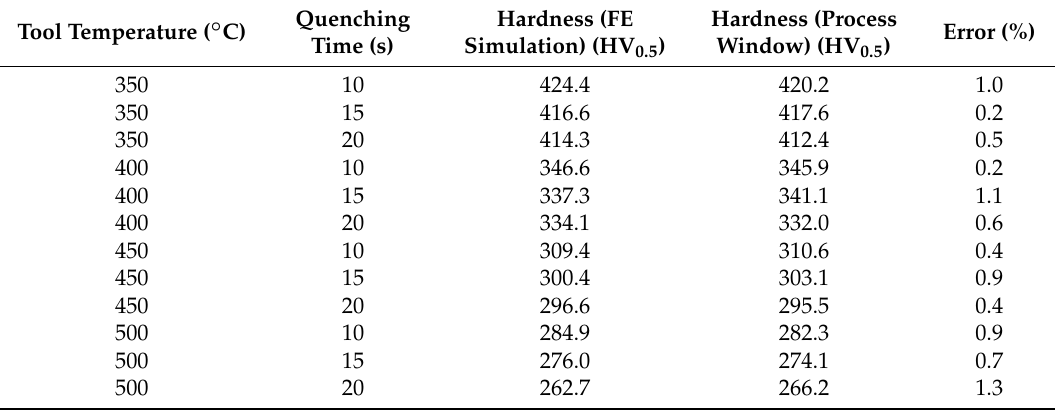
Figure 10. Measurement point of hardness for partially quenched part.